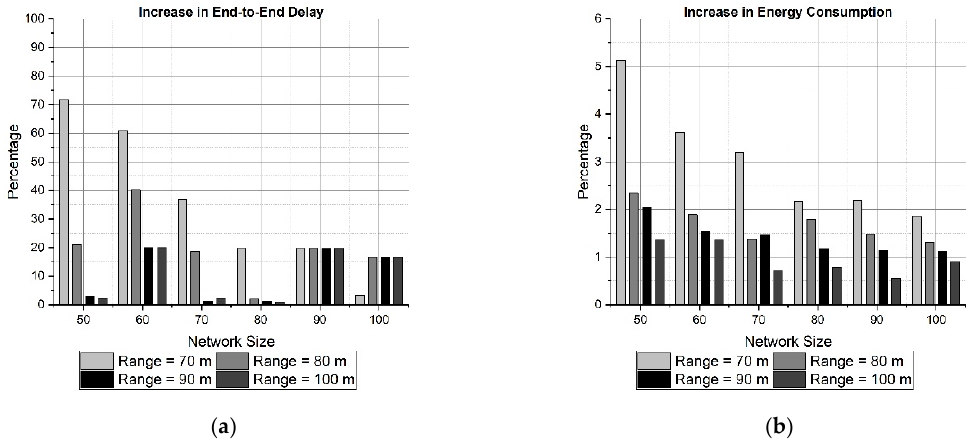
Figure 17. Increase (%) in maximum end-to-end delay ( a ) and in energy consumption ( b ).